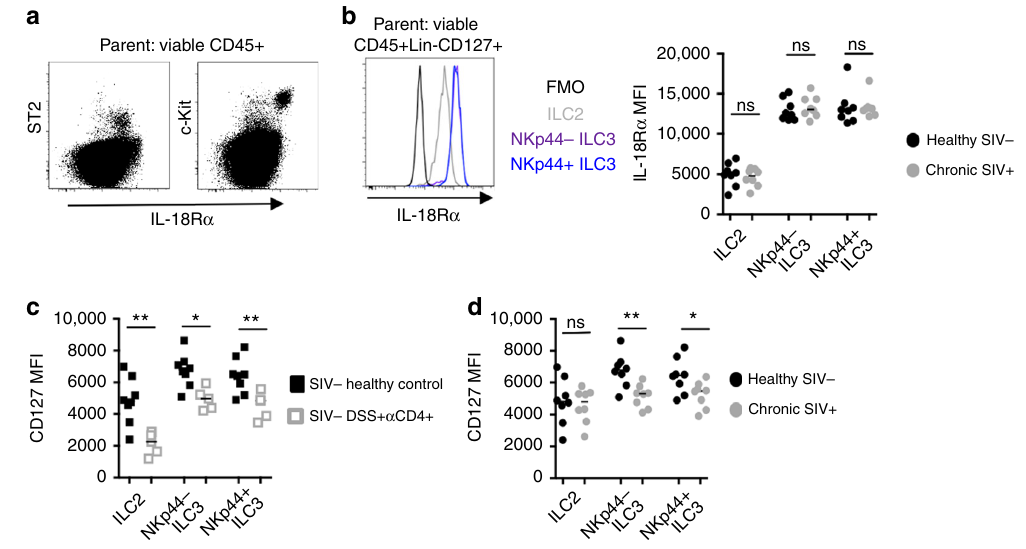
Fig. 7 CD4 depletion in RMs reduces CD127 surface expression on MLN ILCs. a Representative dot plots of IL-18R α expression on ST2 and c-Kit-expressing hematopoietic cells in the MLN. b MLN ILCs were de fi ned by CD127 surface expression and IL-18R α MFI was assessed on MLN ILCs from healthy uninfected ( N = 8) and chronic SIV + RMs ( N = 7). c ILCs were de fi ned by IL-18R α surface expression and CD127 MFI were assessed on MLN ILCs from SIV − healthy control ( N = 8) and DSS + α CD4 + RMs ( N = 5). d Summary data of CD127 surface expression on IL-18R α -expressing ILCs in the SIV- uninfected and chronic SIV + MLN ( N = 7). Statistical signi fi cance in panels b – d were calculated using the Mann-Whitney test. ns = P > 0.05, * = P ≤ 0.05, ** = P ≤ 0.01, *** = P ≤ 0.001, and **** = P ≤ 0.0001